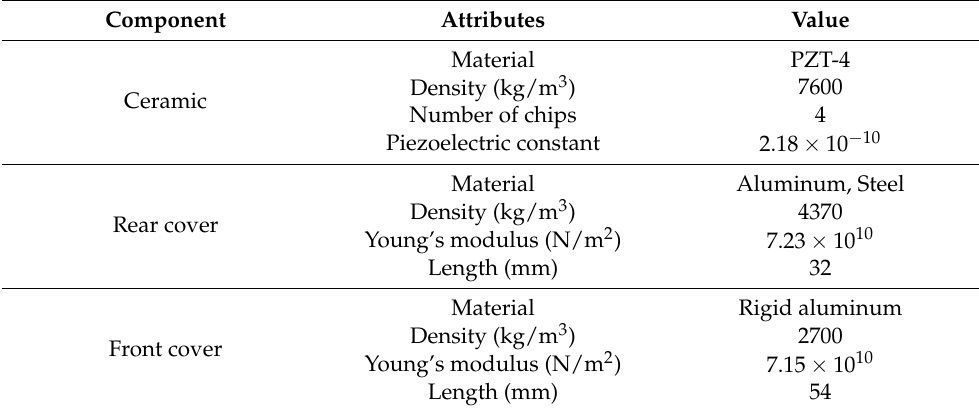
Table 3. Relevant parameters information of the piezoelectric